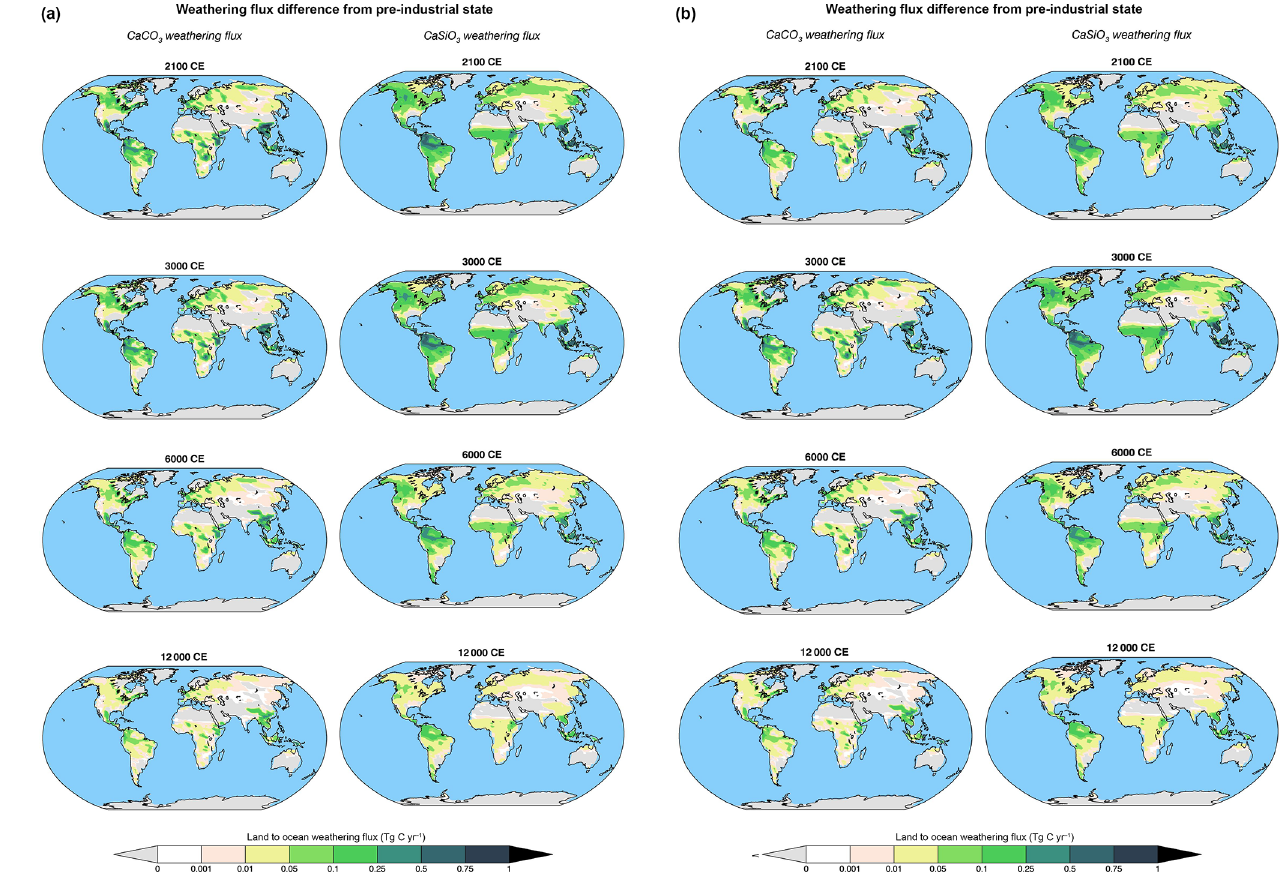
Figure 7. Spatial distribution of changes in carbonate (CaCO 3 ) and silicate (CaSiO 3 ) weathering changes for experiment B1 between pre- industrial steady state (year 1800CE) and years 2100, 3000, 6000, and 12000CE. Note the nonlinear color scale, used to better display values during the later stages of the model